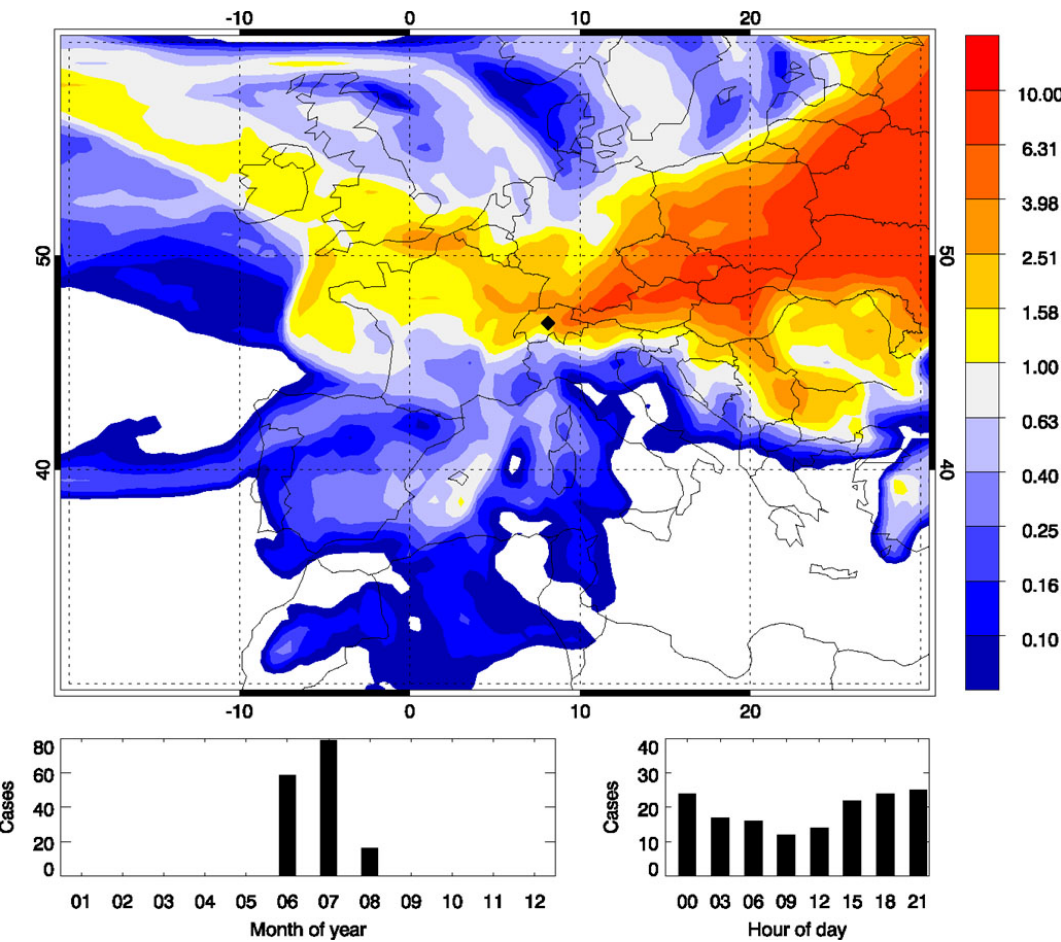
Fig. 12. Relative footprint map associated with low CO 2 and low O 2 and APO concentrations (subset 3). See Fig. 10 for further